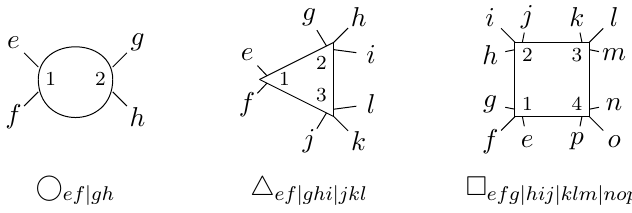
Figure 2 . Graphical representation of the structures entering β abcd (A.1). The numbers encode the positions of index groups (separated by vertical lines) in the corresponding